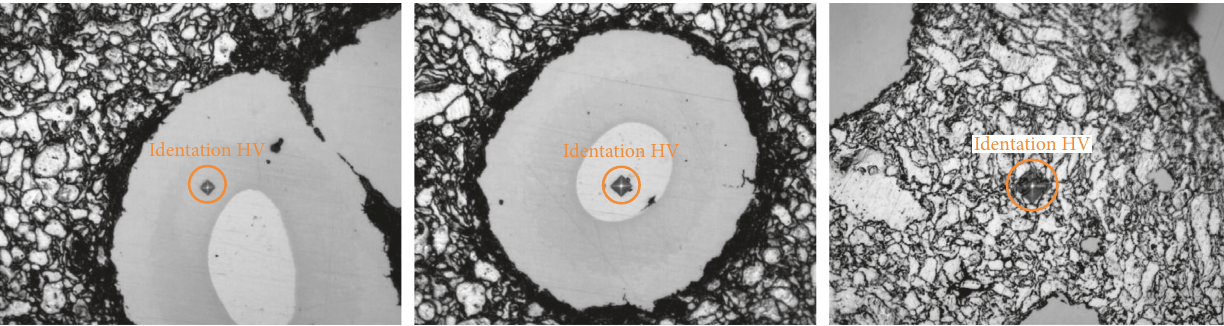
Figure 12: Vickers hardness test of the intermetallic region, showing (a) NiZn phase, (b) Ni phase, (c) Zn phase.